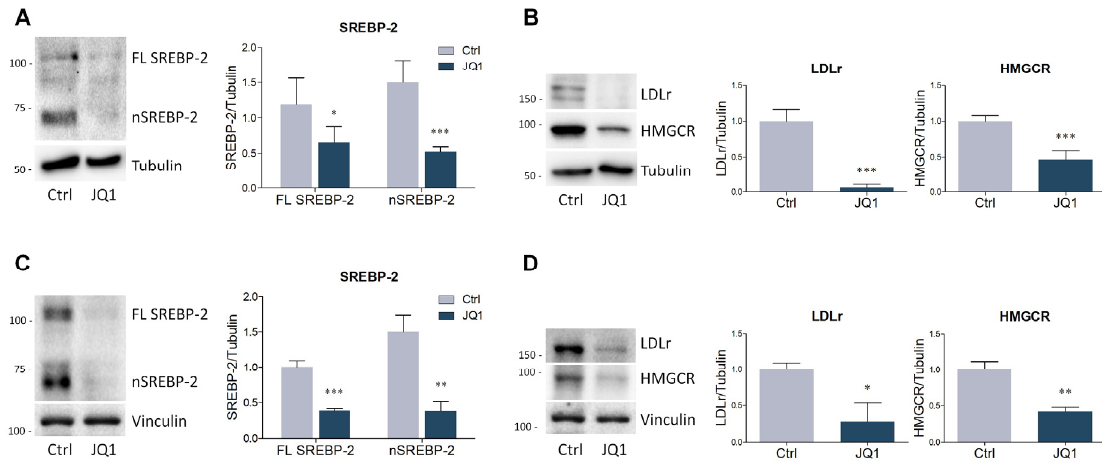
Figure 5. BET inhibition modulates the expression of SREBP-2, HMGCR and LDLr in di ff erent cell lines. ( A–B ) Representative Western blot and densitometric analysis of SREBP-2, HMGCR and LDLr in di ff erentiated N1E-115 treated with JQ1 (0.1 µ M) for 48 hours. ( C–D ) Representative Western blot and densitometric analysis of SREBP-2, HMGCR and LDLr in primary human fibroblasts treated with JQ1 (0.4 µ M) for 48 hours. n = 3 di ff erent experiments. Tubulin and vinculin were used as